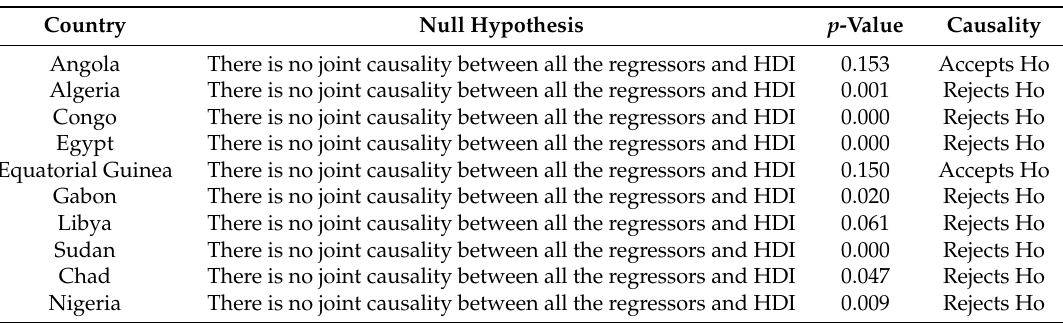
Table 15. ECT joint causality summary.